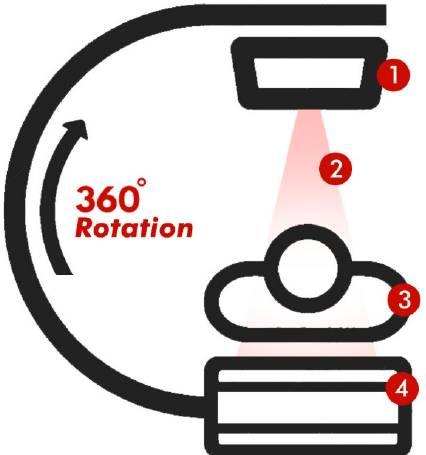
Figure 1. A medical X-ray computed tomography imaging system: (1) X-ray tube, (2) conical X-ray beam, (3) patient, and (4) detector.